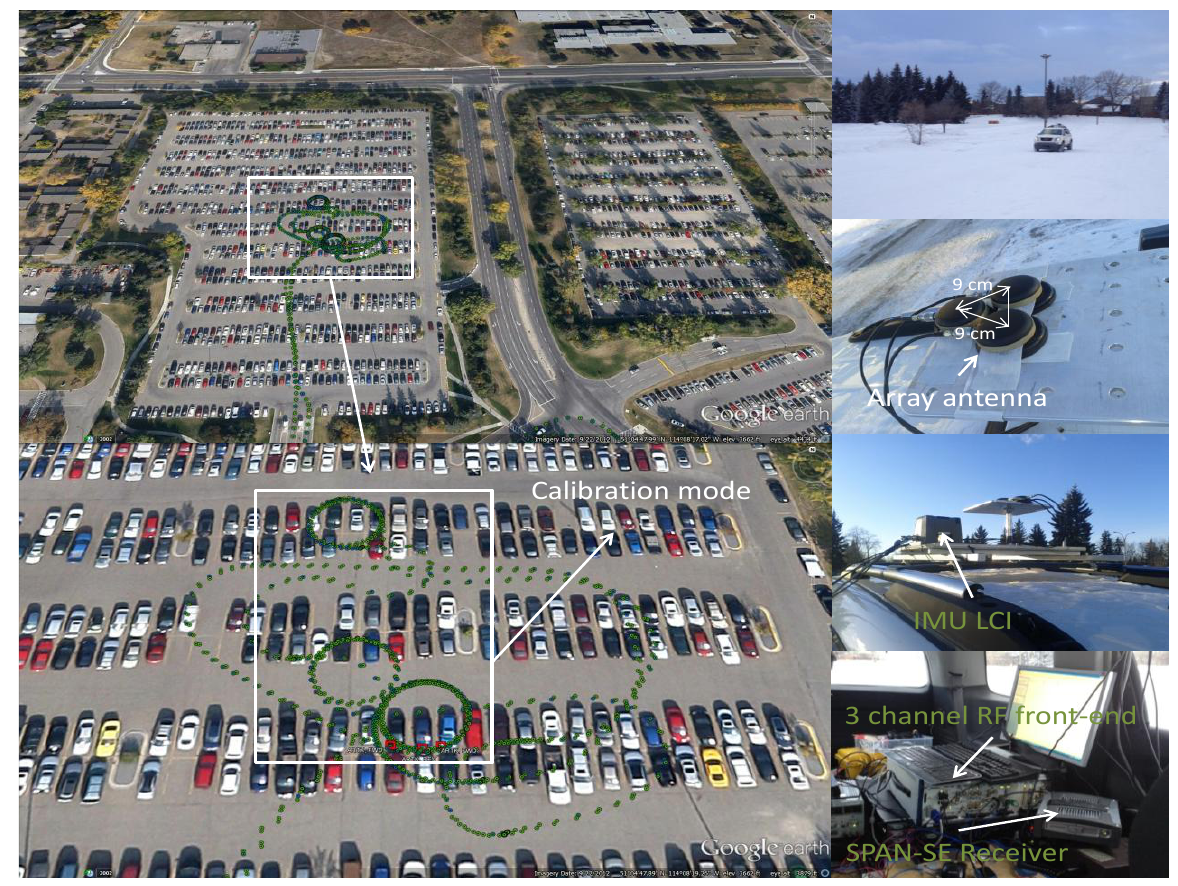
Figure 4. Data collection set